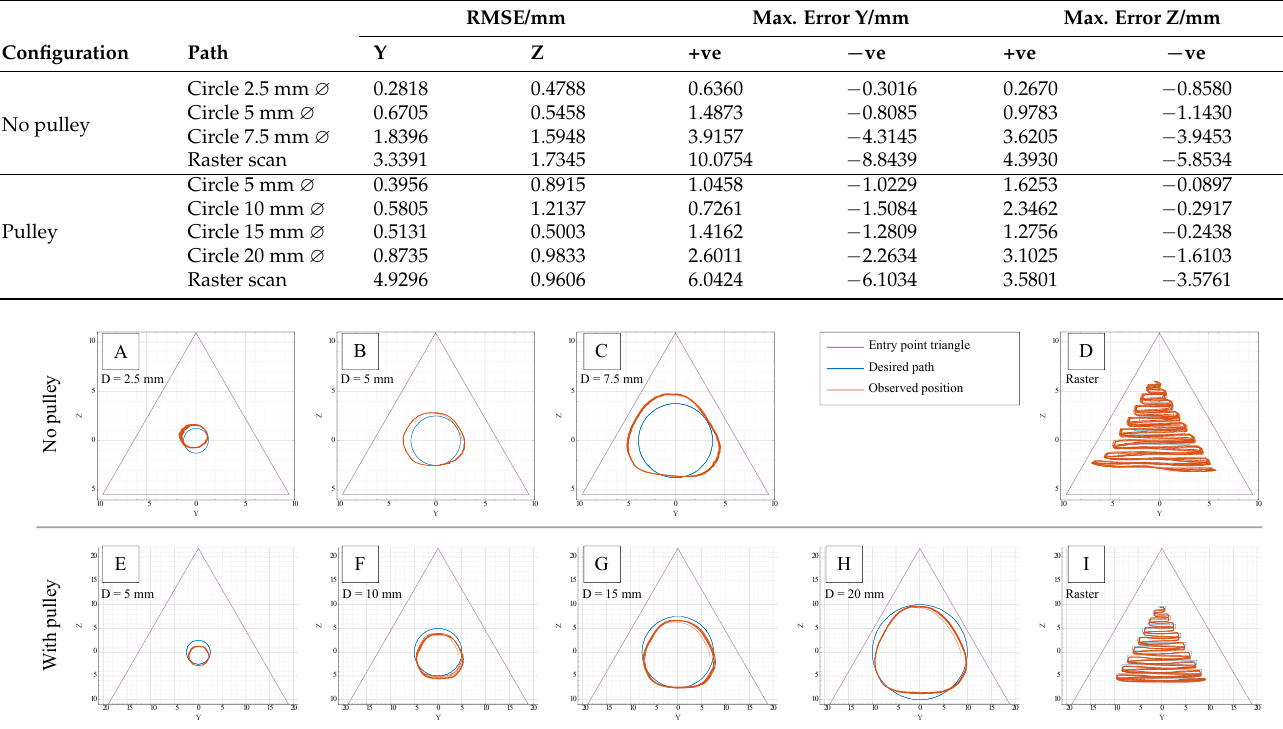
Figure 7. Results of path following tests for the two-DOF setup. ( A ) Circle diameter of 2.5 mm, no pulleys. ( B ) 5 mm diameter, no pulleys. ( C ) 7.5 diameter, no pulleys. ( D ) Raster scan pattern, no pulleys. ( E ) Circle diameter 5 mm, with pulleys. ( F ) 10 mm diameter, with pulleys. ( G ) 15 mm diameter, with pulleys. ( H ) 20 mm diameter, with pulleys. ( I ) Raster scan pattern, with